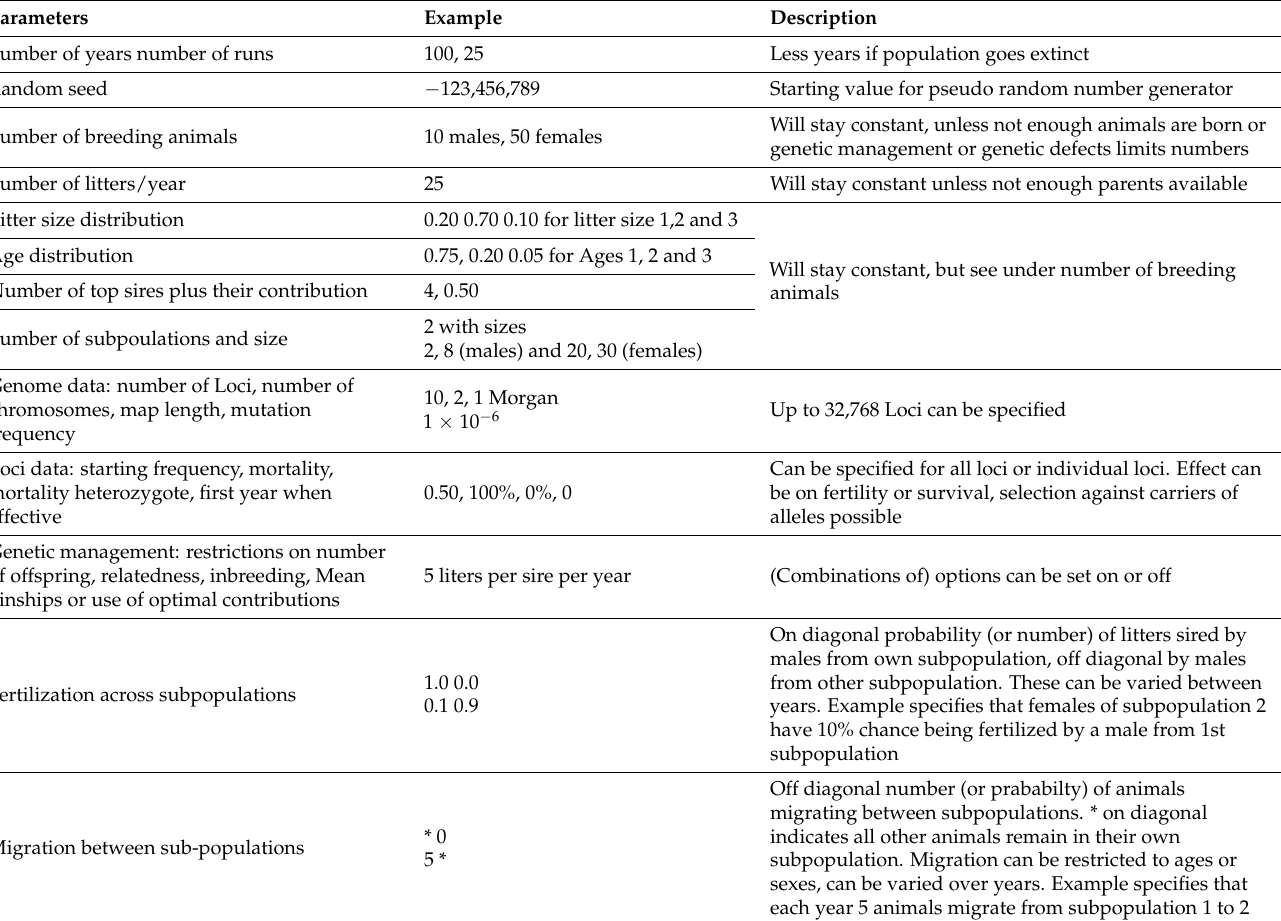
Table 2. Overview of input for the Pointer software.